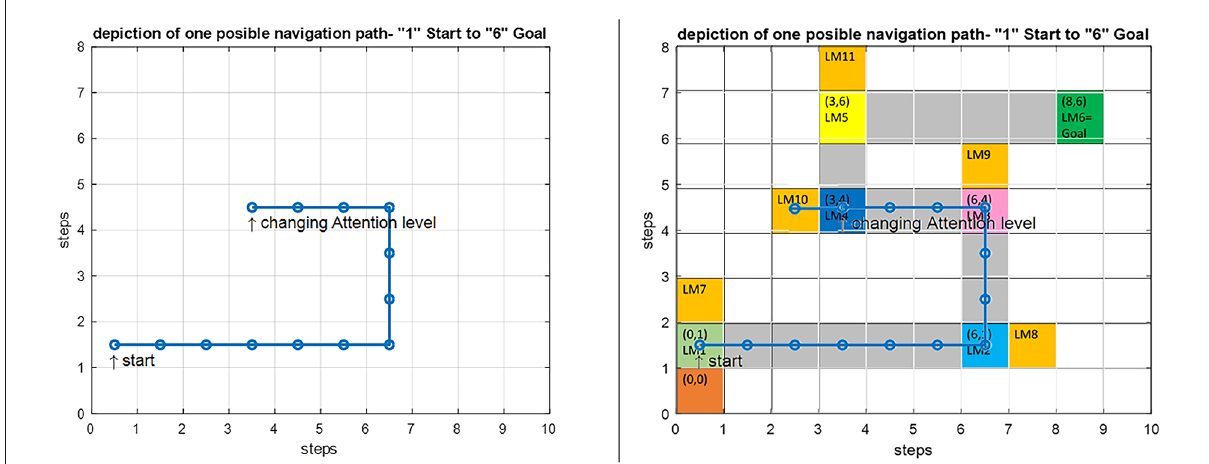
FIGURE13 Left: Simulation result for the implemented navigation with attention deficit model in Matlab. Right: An overlay of the simulation output on the predefined route. By introducing a drop in the attention level at LM4, the agent deviates from the route and enters the wrong path denoted by LM10, and stays there until the attention level is raised to correct the